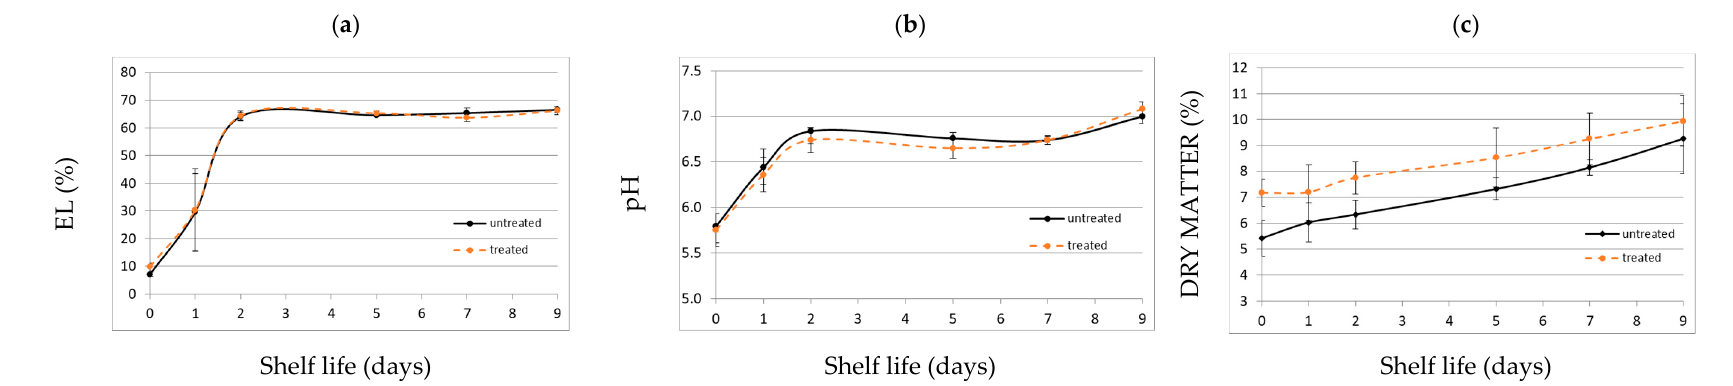
Figure 6. Evolution of EL ( a ), pH ( b ), and dry matter content ( c ) for untreated and treated samples over shelf life (mean values ± standard error). There were no significant differences between time points, according to the ANOVA followed by Sidak post-hoc test ( p < 0.05; n = 3).